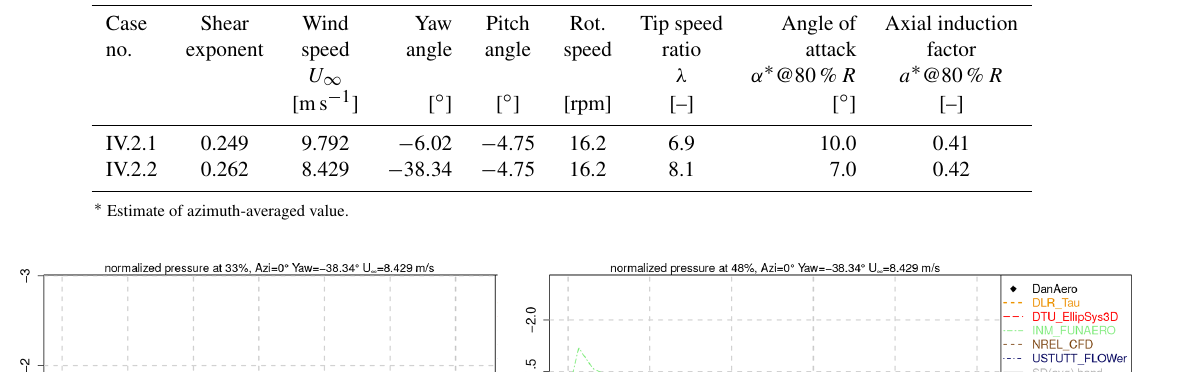
Table 4. DanAero comparison cases (shear and yawed flow).